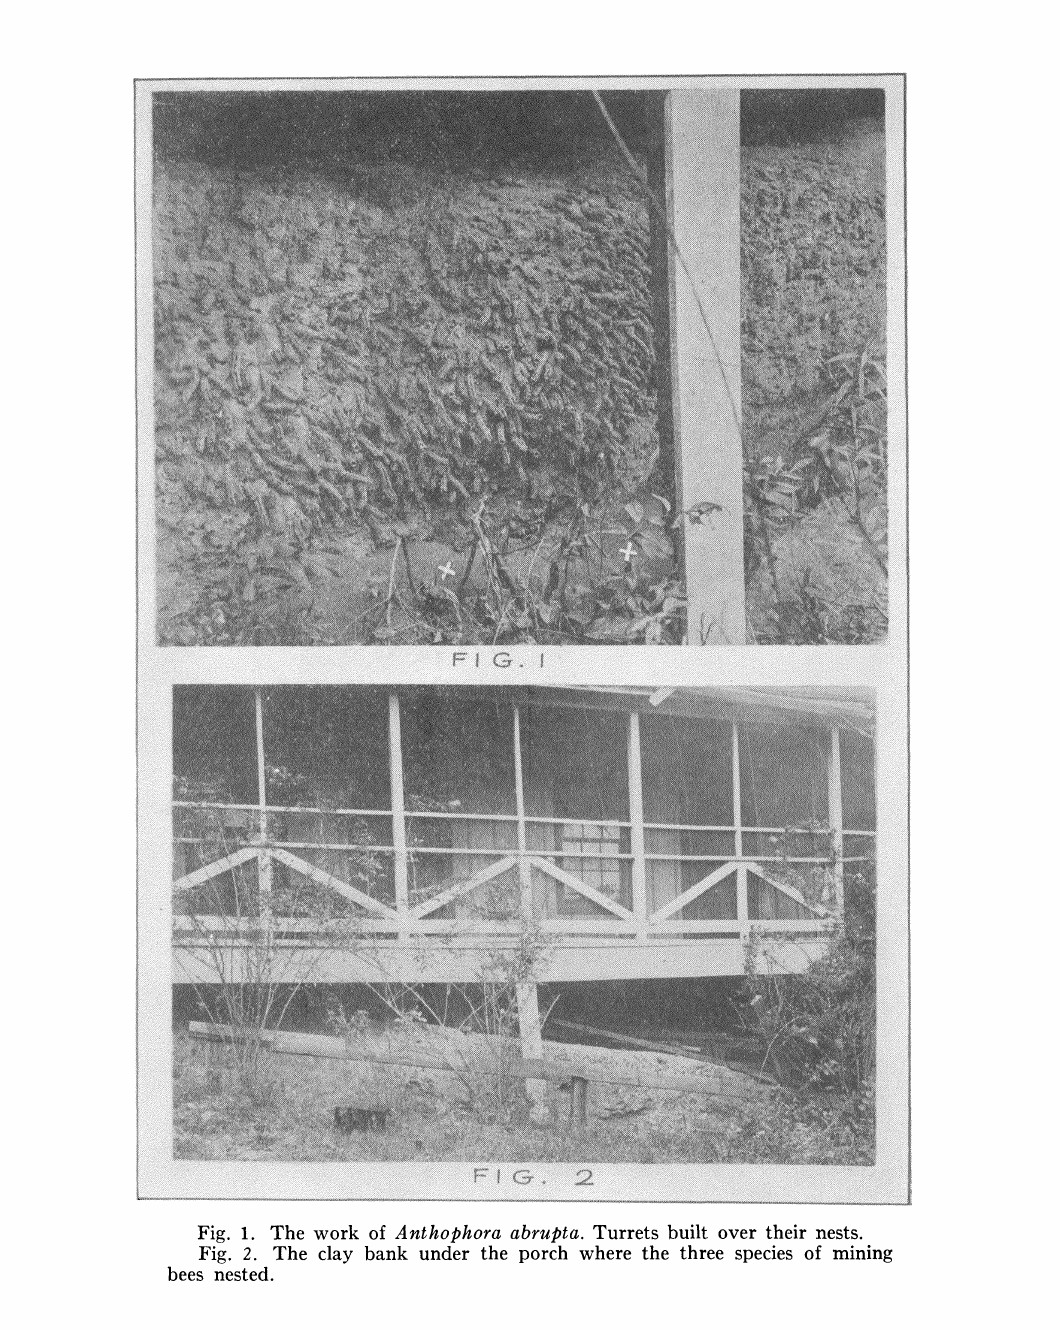
Fig. 1. The work of Anthophora abrupta. Turrets built over their nests. Fig. 2. The clay bank under the porch where the three species of mining bees